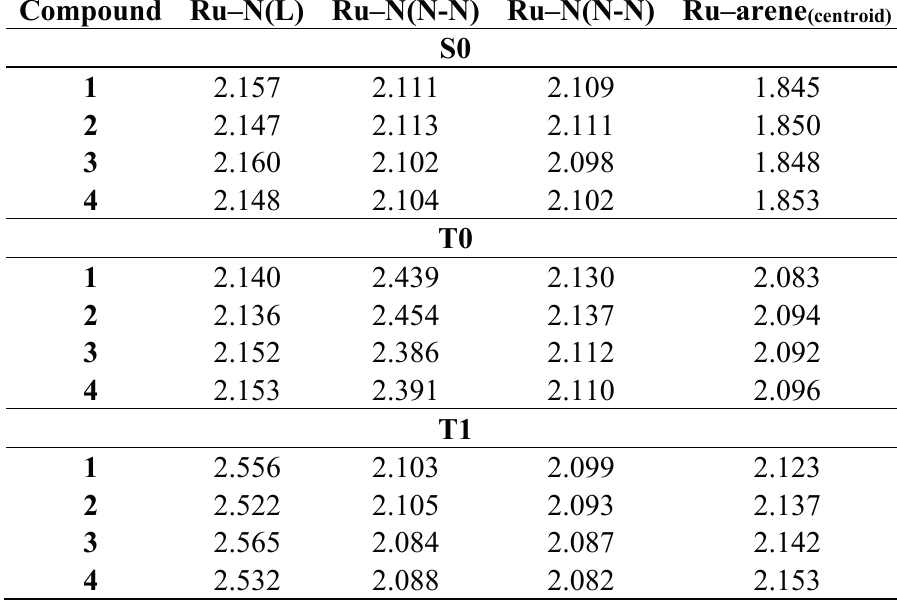
Table 3. Selected calculated bond distances (Å) for 1 – 4 in the ground state (S0) and lowest-lying triplet state (T0 and T1)